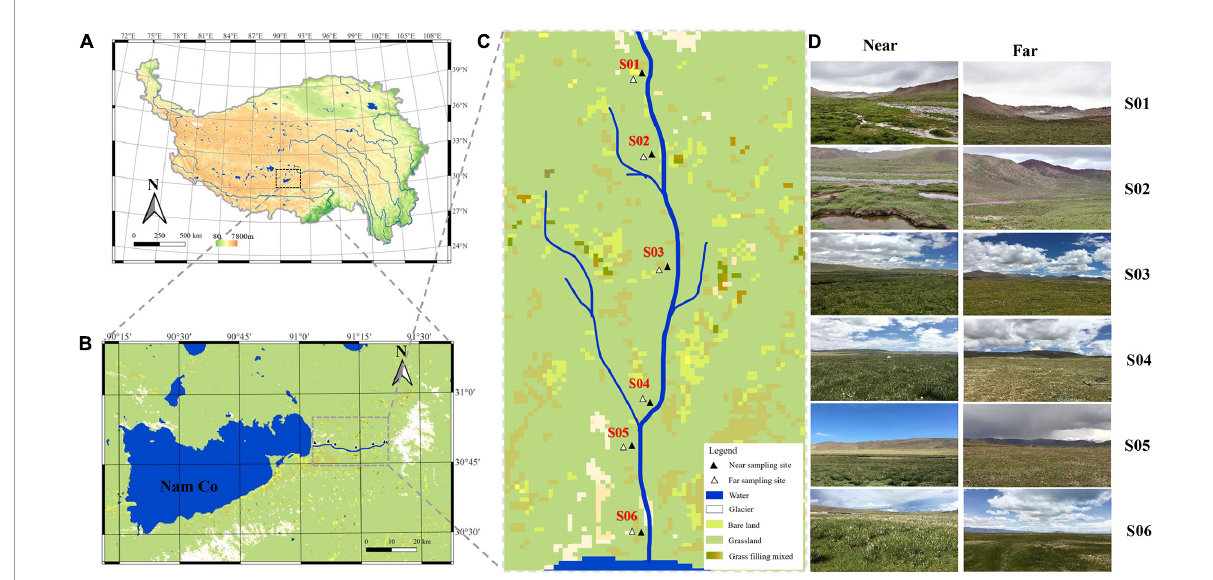
FIGURE1 Maps showing locations of the sampling sites: (A) Location of Nam Co in the Qinghai-Tibet Plateau. (B) Map of a panoramic view of the Nam Co area marked with Niyaquriver. (C) Map of a magnified view of the Niyaqu basin with the six sampling sites labeled as S01–S06 along the river. (D) View of the sampling sites along the Niyaquriver in the Nam Co